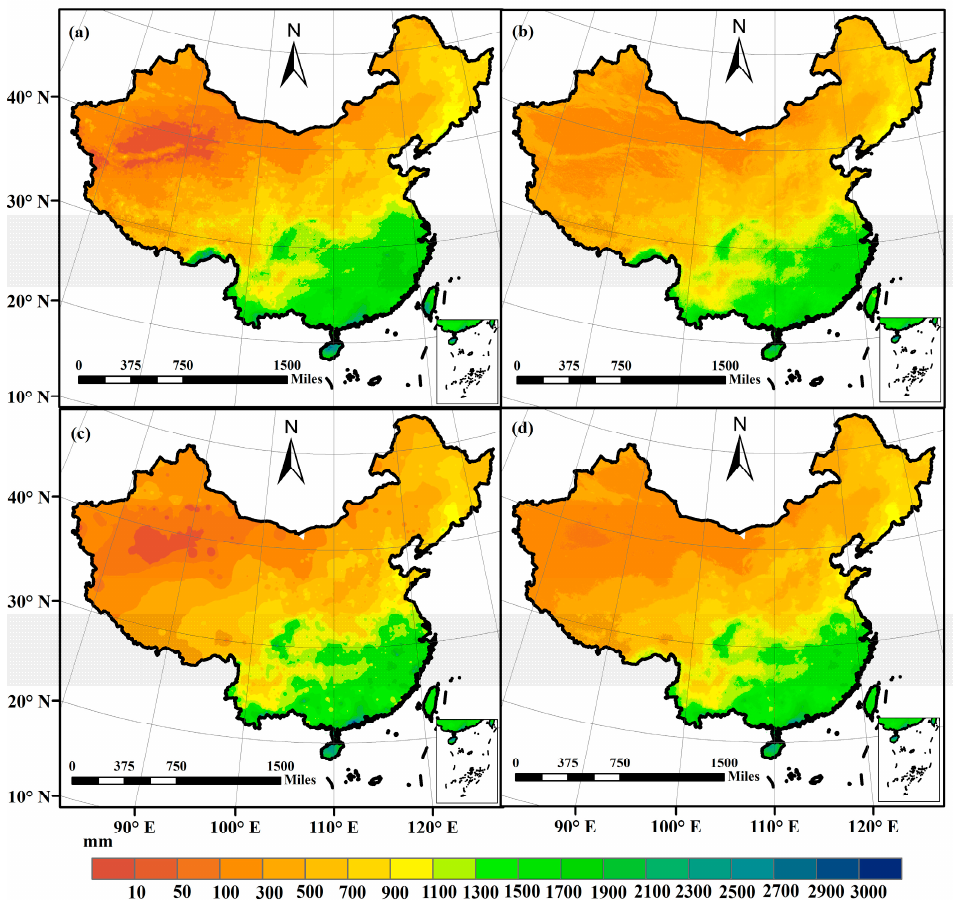
Figure 3. Precipitation estimates in the year 2018. ( a ) IMERG; ( b ) RF; ( c ) IDW; ( d ) The merg- ing